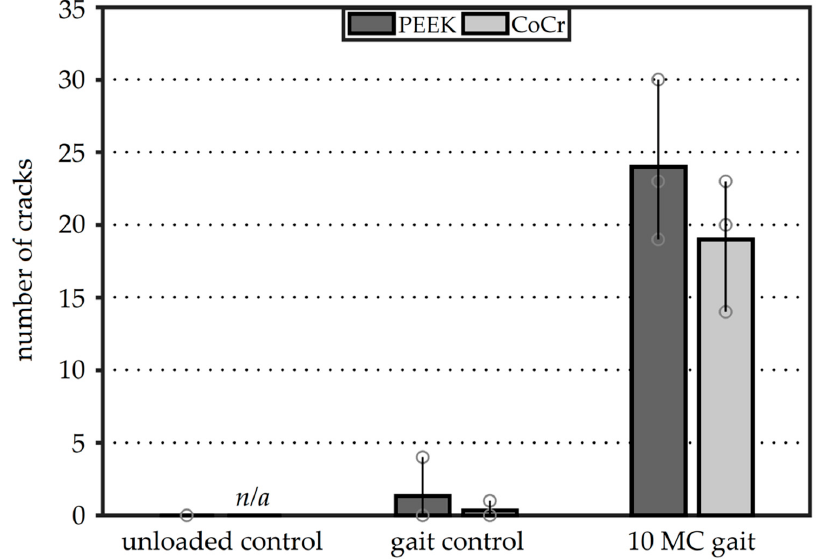
Figure 7. The average number of full-thickness cracks for the three experimental groups. The bars show the range of observations with the individual specimens shown as circles.